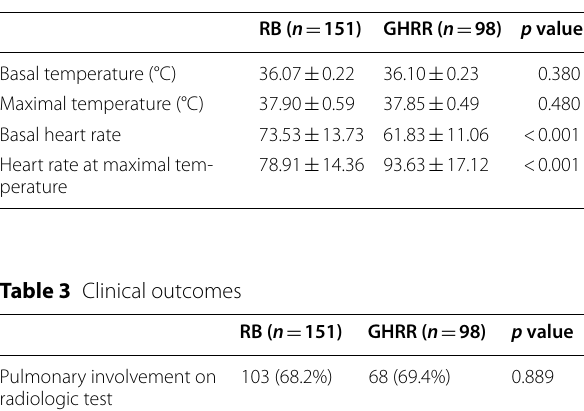
Table 2 Alternation of body temperature and heart rate